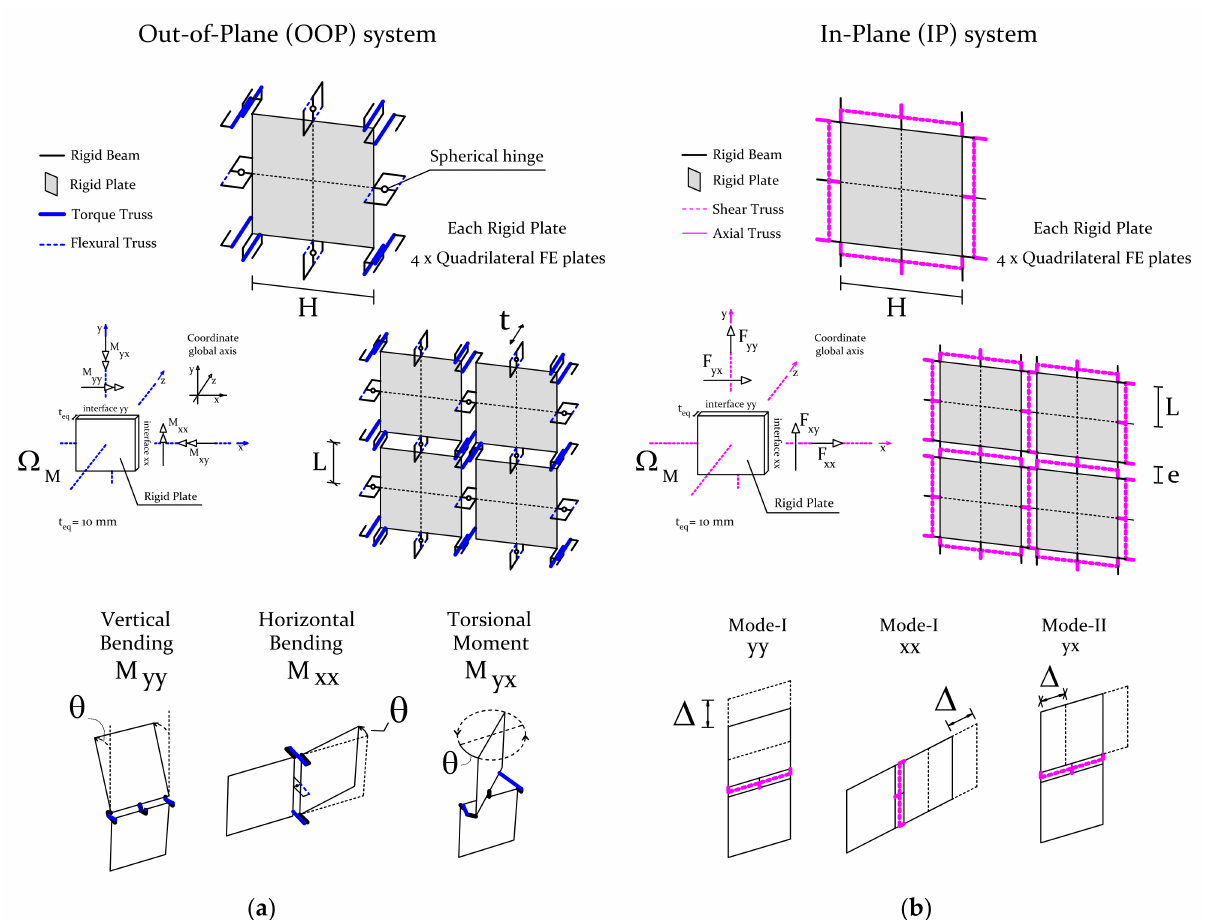
Figure 1. Macro–unit cell and kinematics of the macro–element. ( a ) Out–of–plane. ( b )